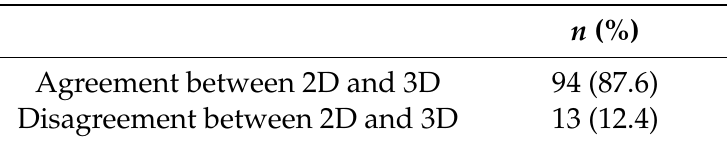
Table 4. An analysis of agreement and disagreement between 2D and 3D radiographic healing assessment of one-year after the apical surgery. The total number of cases and rates of agreement and disagreement between 2D and 3D radiographic